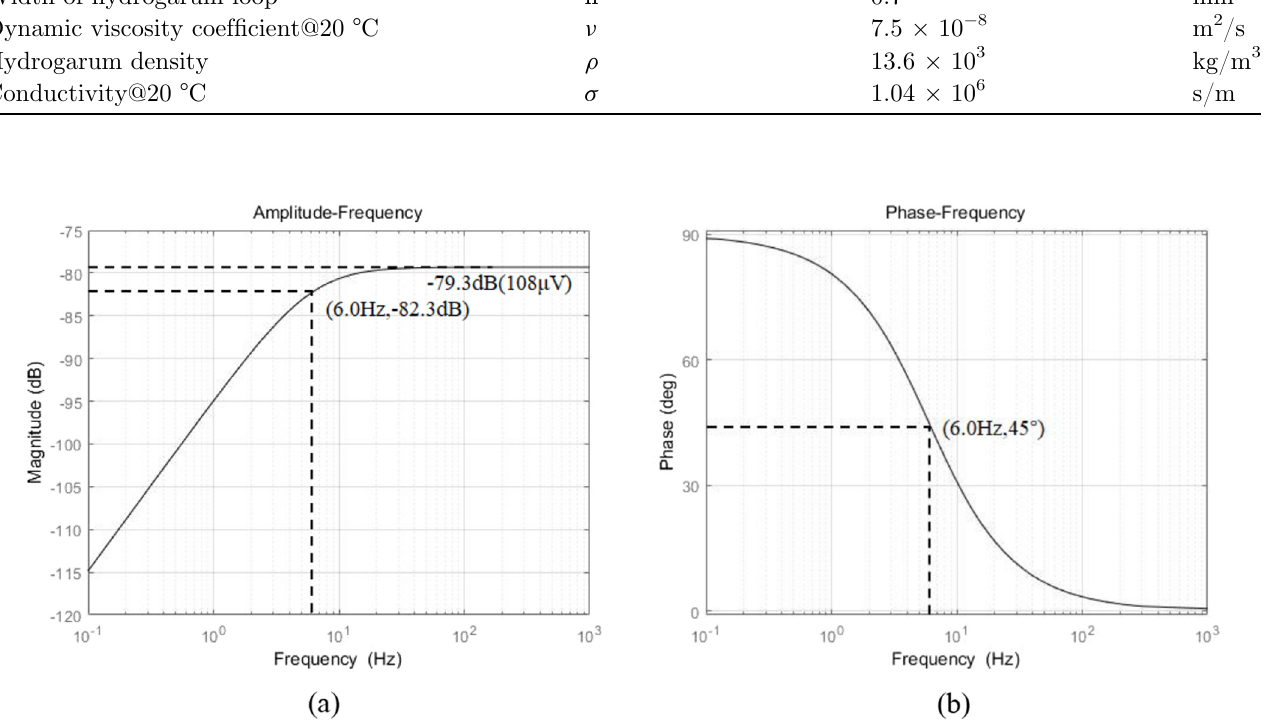
Fig. 4. Frequency characteristics of MHD angular vibration sensor. (a) Amplitude-frequency responses. (b) Phase-frequency